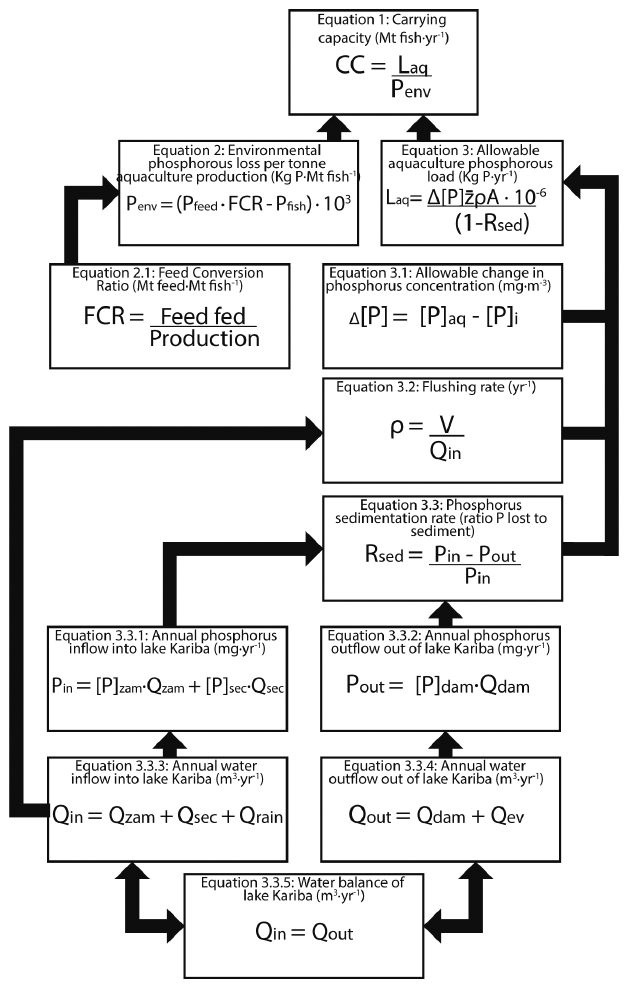
Fig. 2. Flow chart of equations used in this study in order to calculate the carrying capacity of Lake Kariba. See Table 2 for a description of all variables used in these